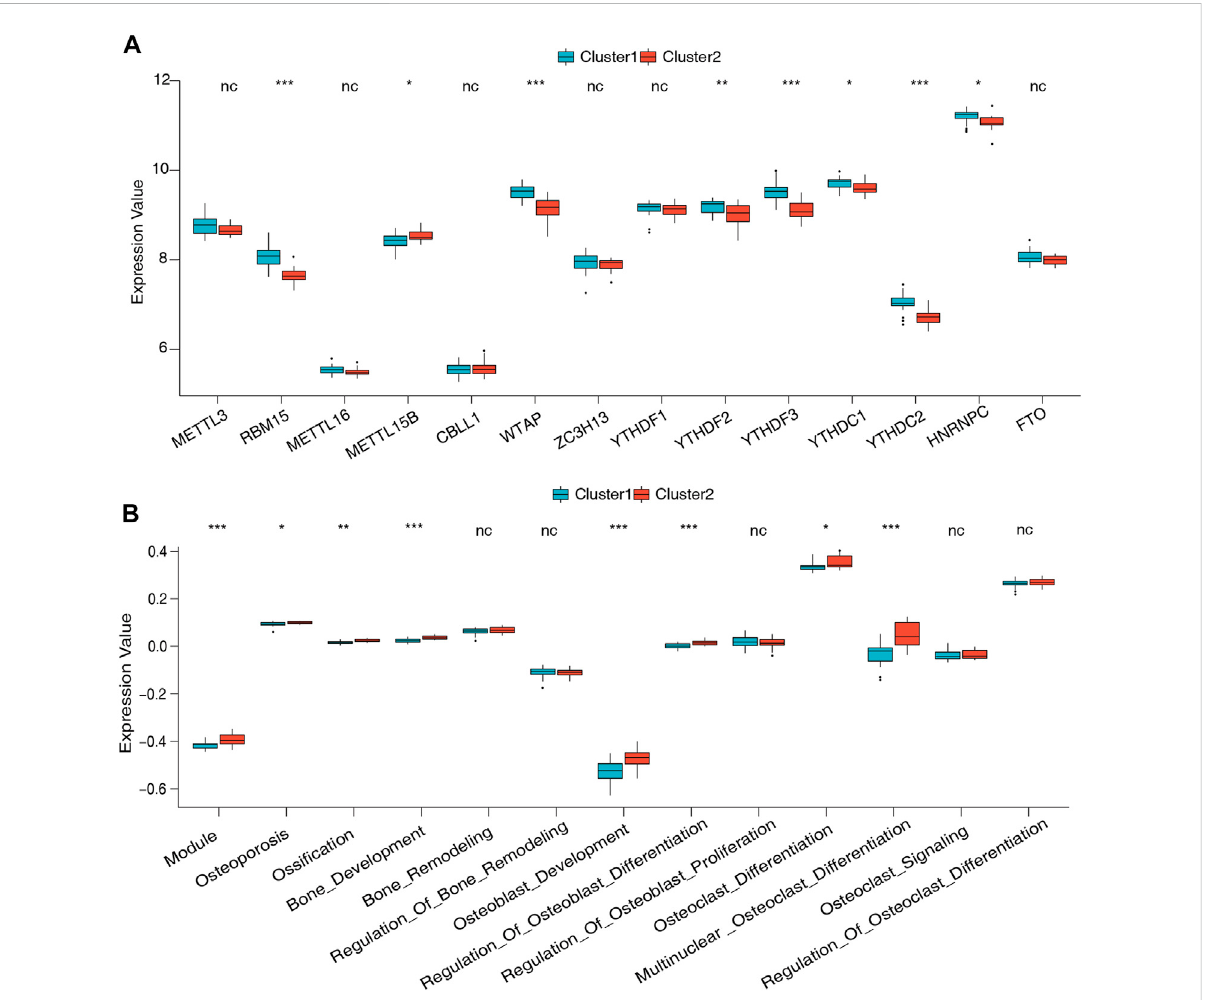
Expression ofthem6Aregulatorsand bonemetabolism characteristicsbetweenthetwom6A modi fi cationpatterns. (A) Expression differences of 14 m6A regulators in the two m6A modi fi cation patterns. (B) Differences in the abundance and activity of bone metabolism-related gene sets in the two m6A modi fi cation